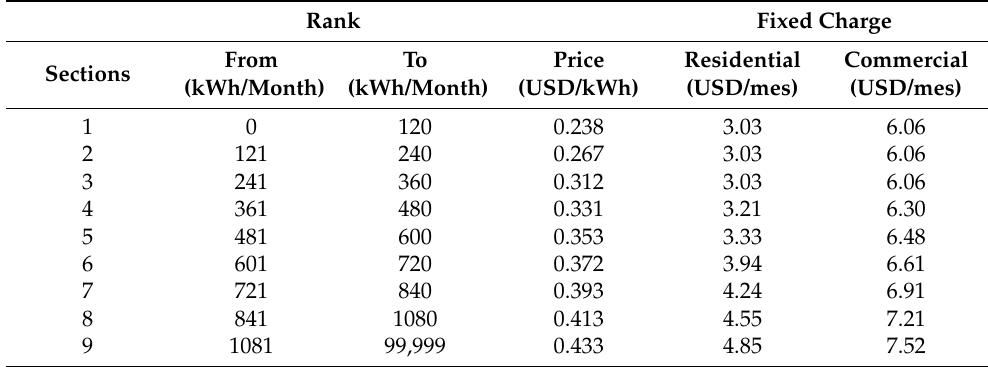
Table 1. Current tariff scheme of CESPA.